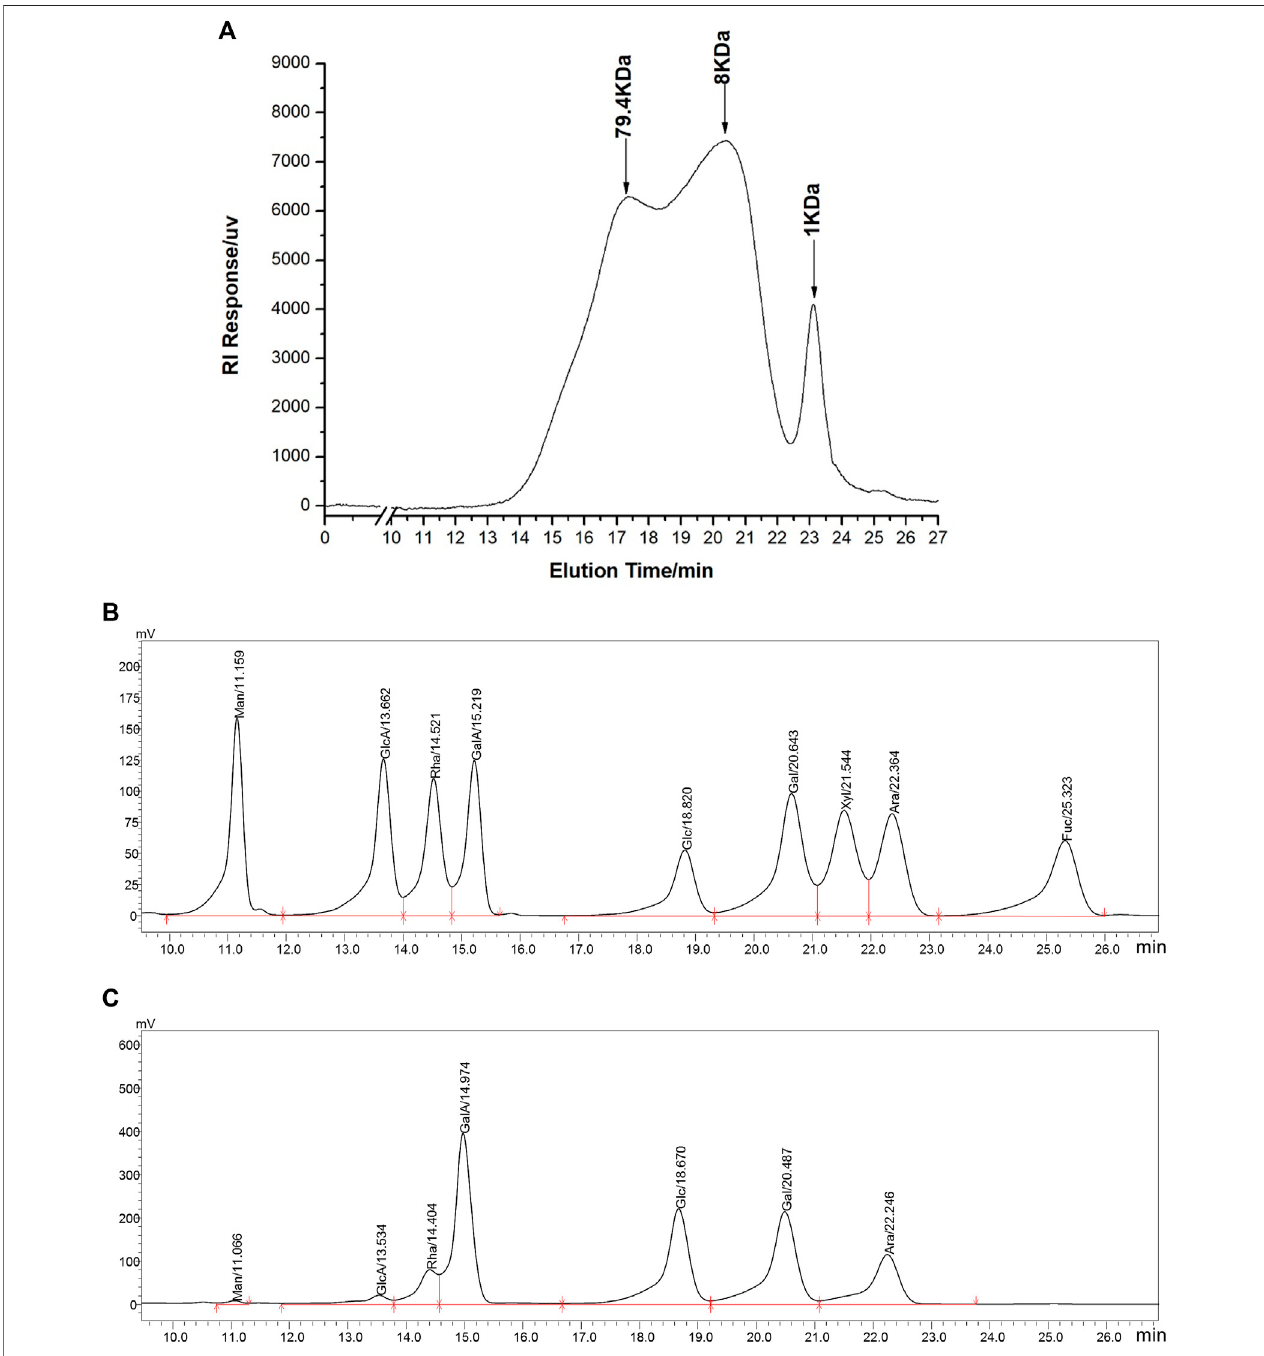
FIGURE 1 | Chromatographic analysis of WGP. HPGPC was used to determine WGP molecular weight distribution (A) . HPLC was used to separate monosaccharide standards (B) and analysis the monosaccharides composition in WGP (C) . Man, GlcA, Rha, GalA, Glc, Gal, Xyl, Ara, and Fuc represent mannose, glucuronic acid, rhamnose, galacturonic acid, glucose, galactose, xylose, arabinose, and fucose, respectively.